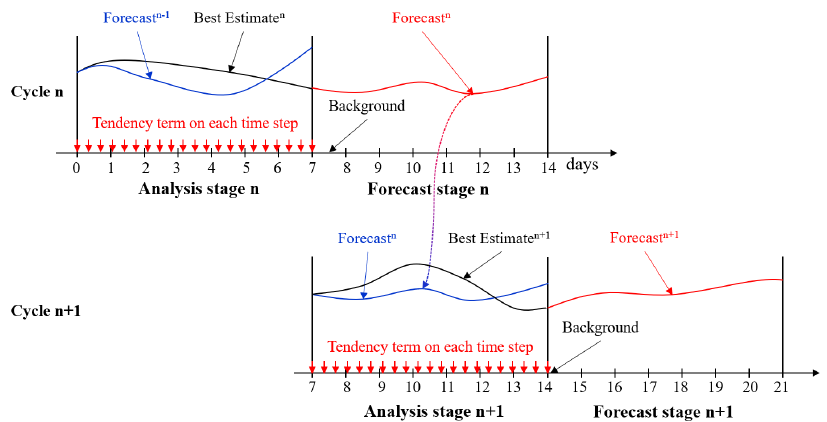
Figure 9. Schematic representation of the data assimilation procedure for two consecutive cycles, n and n + 1, in SCSOFSv2 while consid- ering the FGAT and IAU methods.